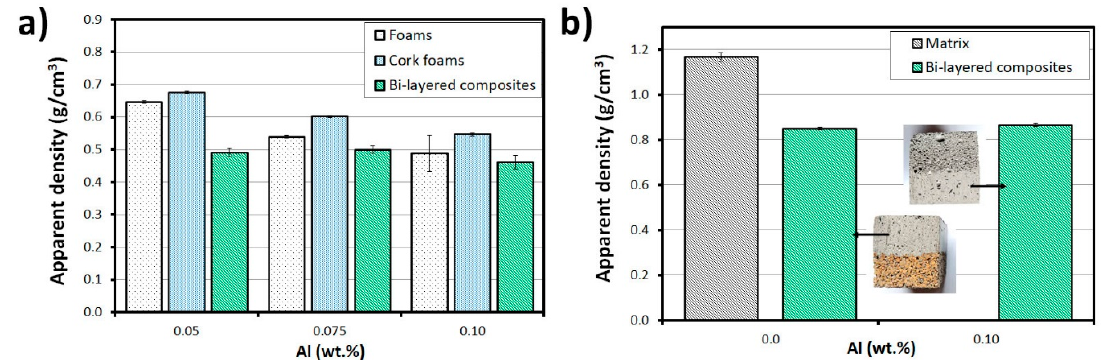
Figure 6. ( a ) Influence of the Al powder amount on the apparent density of the various compositions. ( b ) presents the apparent density of the matrix and of the bi-layered composites prepared without foaming agent and without cork. The microstructure of these bi-layered specimens is lustrated by the inset digital photographs.